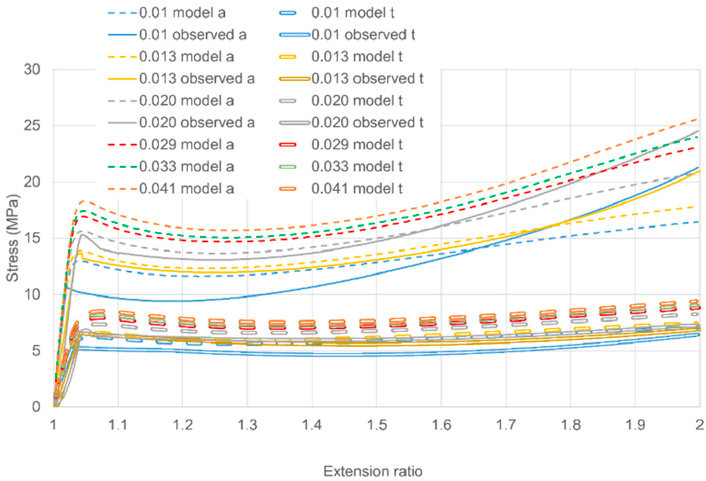
Figure 12. Planar stress-strain curves in loading for the six highest strain rates. The key shows octa- hedral strain rates in s − 1 and also distinguishes axial (a) and transverse (t) stresses. The observations at the three highest rates are omitted as they are inconsistent with those at lower rates, apparently because of adiabatic heating.